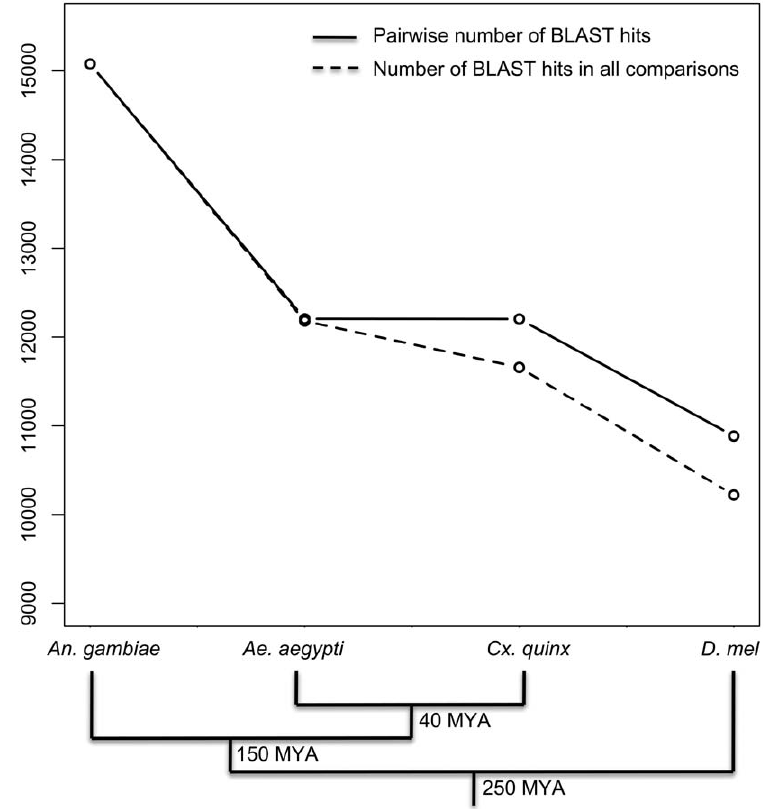
Figure 3. Homology with Dipteran transcriptomes decreases with increasing phylogentic difference. The number of An. funestus contigs with significant BLAST hits in pairwise comparisons to An. gambiae, Ae. aegypti, C. quinquefasciatus and D. melanogaster is plotted. Note that the y-axis only spans 9,000 to 15,000. The solid line indicates the total number of contigs with a significant BLAST hit in each comparison. The dashed line indicates the number of contigs with a significant BLAST hit in all comparisons as phylogenetic distance increases. The phylogenetic tree at the bottom of the panel depicts the evolutionary relationships between the Dipteran insects used in pairwise BLAST comparisons, with estimated divergence times (in millions of years) at each node (adapted from [53]).